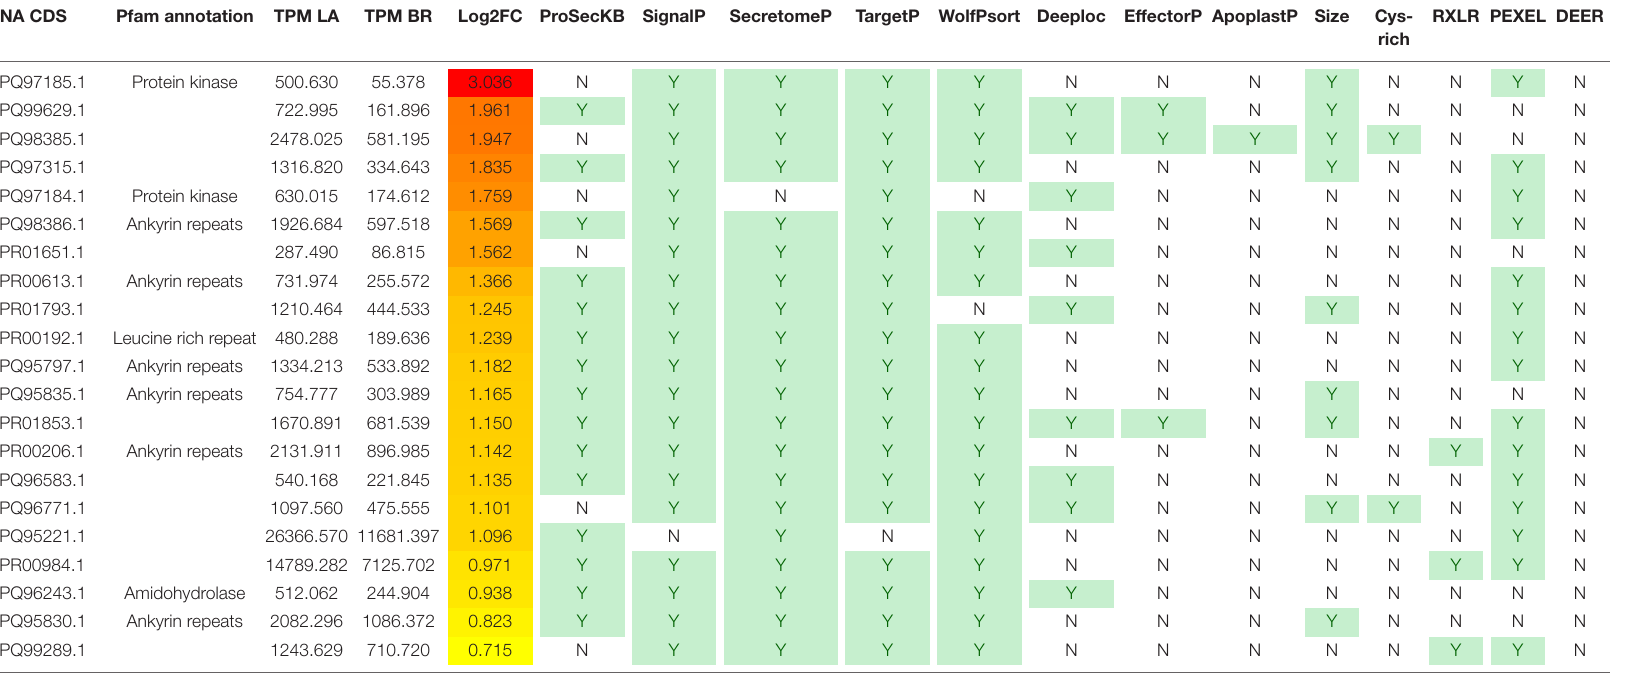
TABLE 1 | Secretome prediction of differentially expressed P. brassicae transcripts 21